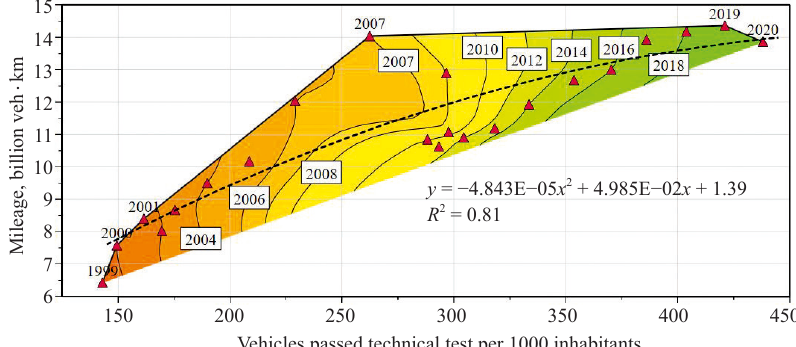
Figure 3. Vehicle total mileage growth in Latvia